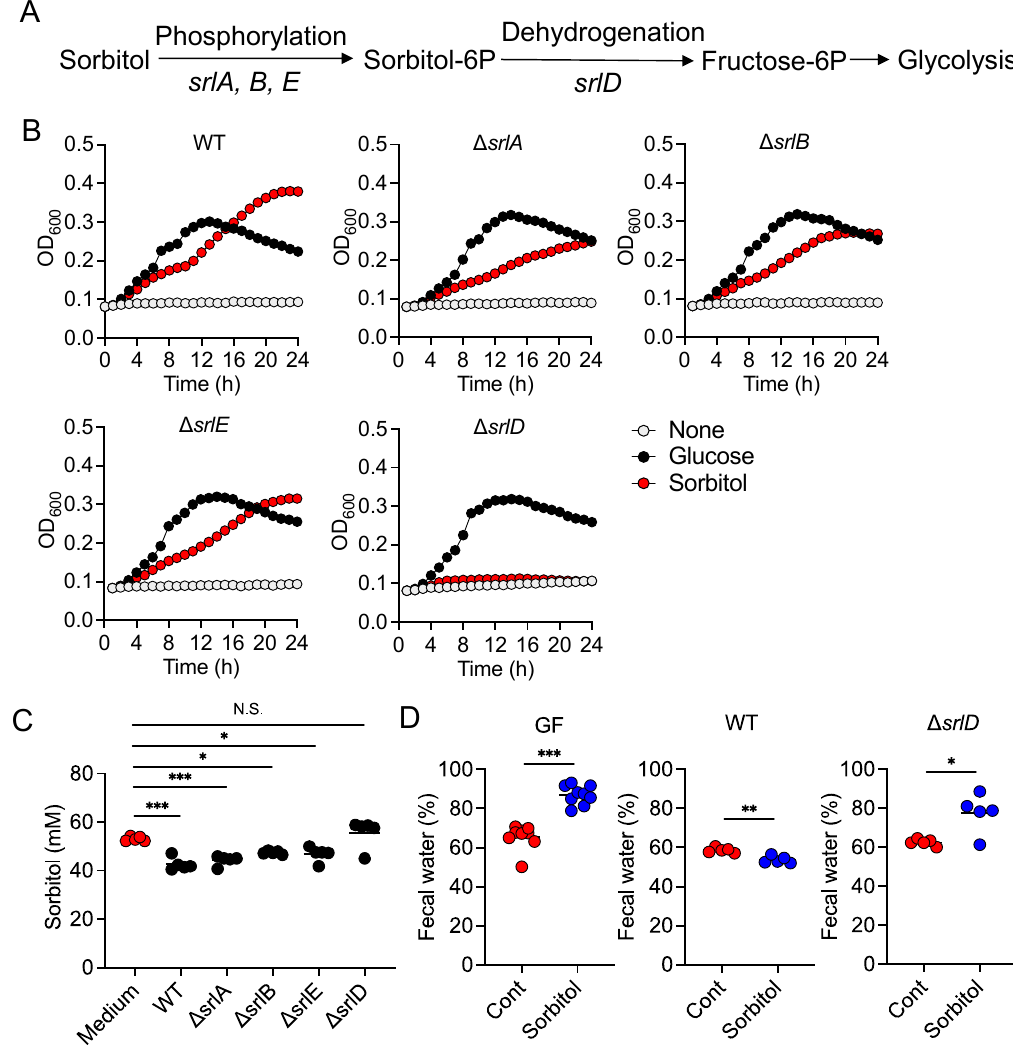
Figure 4. srlD Is Required for Suppression of Sorbitol-Induced Diarrhea by Escherichia coli . ( A ) The pathway of sorbitol metabolism. ( B ) WT and srlA , srlB , srlE , or srlD mutants of E. coli were grown in M9 medium or M9 medium supplemented with 1% glucose or sorbitol and optical density (O. D.) at 600 nm was measured over time. ( C ) Sorbitol concentration in 24 h culture supernatants of WT or mutant E. coli strains ( n = 5). Horizontal bars are mean values. * p < 0.05, *** p < 0.001, compared with the control (Medium) group using Dunnett’s t -test. ( D ) ICR Germ-free (GF) mice or GF mice colonized with WT or srlD mutant of E. coli were provided drinking water containing 5% sorbitol for 4 days. Fecal water content at day 0 and 4 after treatment with 5% sorbitol was assessed. Each dot represents an individual mouse and the horizontal bars indicate mean values. * p < 0.05, ** p < 0.01, *** p < 0.001 by Welch’s t -test. WT, wild-type E. coli . N.S., not